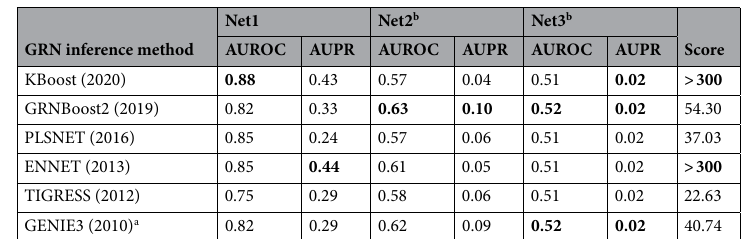
Table 3. DREAM 5 dataset benchmark. a Winner of the DREAM 5 challenge which included 351 algorithms. b In the original DREAM 5 dataset, Net 2 and 3 are labeled 3 and 4. The best performance in each column is in bold.